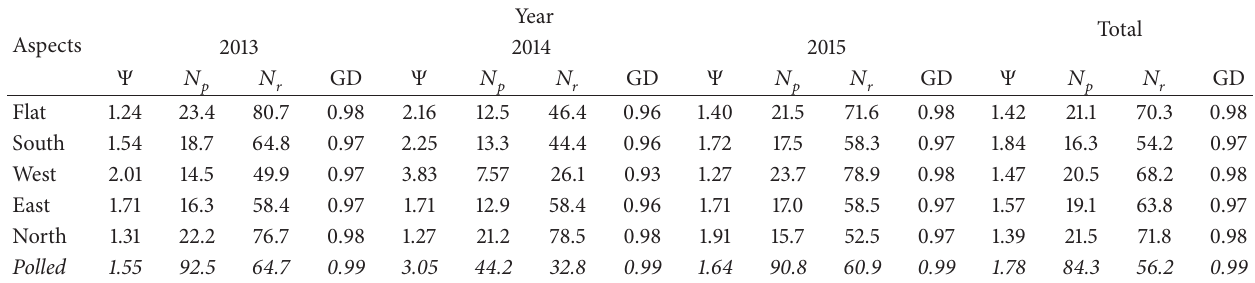
Table 3: Fertility variation (Ψ) , effective number of parents (𝑁 𝑝 ) , relative effective number of parents (𝑁 𝑟 ) , and gene diversity (GD) for the aspects and